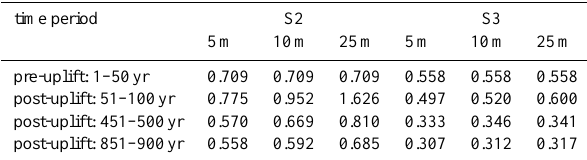
Table 2. Variability of relative sediment yield in uplift scenarios for 900yr